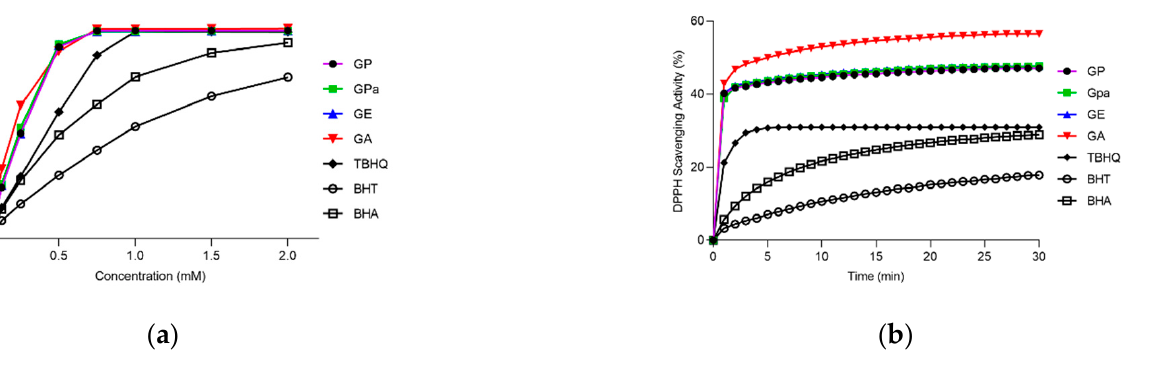
Figure 5. DPPH radical scavenging activity in different concentrations ( a ) and time ( b ).